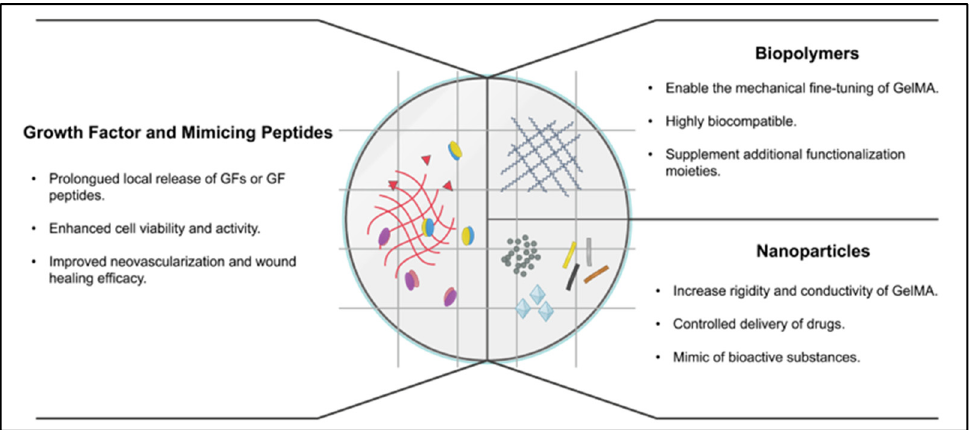
Figure 1. Different modifications of GelMA hydrogel and their benefits.